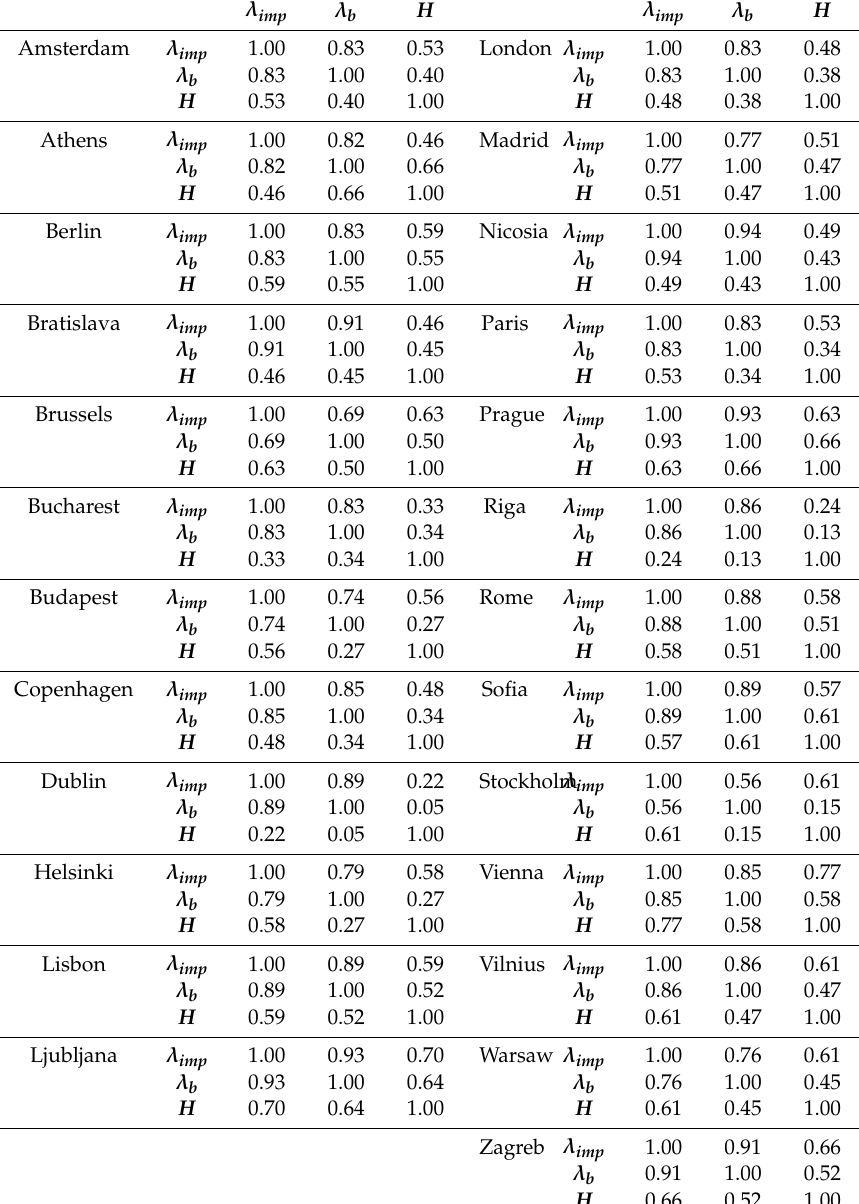
Table A1. Pairwise Spearman’s rho linear correlations among λ imp , λ b , and H . λ